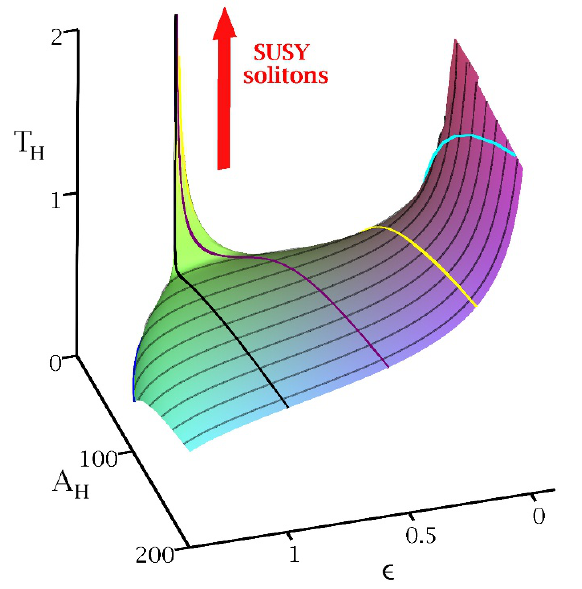
Figure 8. Area A H vs. horizon deformation (cid:15) vs. temperature T H for black holes is shown for the same solutions in (cid:12)gure 7. As the temperature diverges, the horizon area vanishes and the susy solitons are